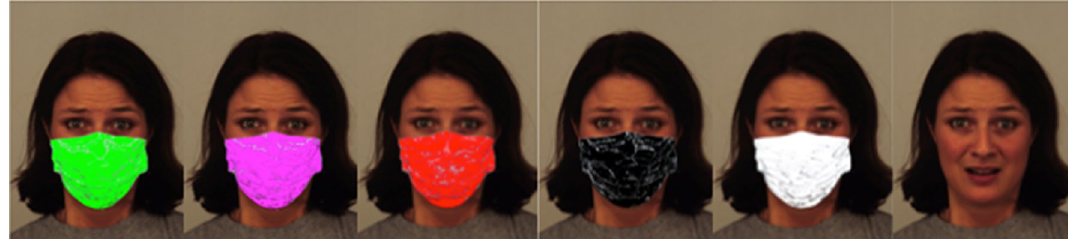
Figure 1. Example of a manipulated Karolinska emotional face displaying fear duplicated in the different mask conditions (green, pink, red, black, white and